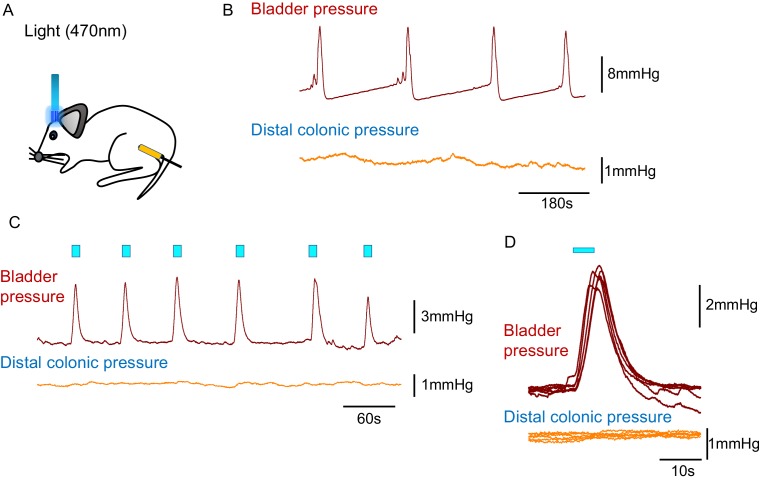
BarrCRH optoactivation does not cause contraction of the distal colon.(A, B) Simultaneous recording of bladder pressure and rectal pressure with an intraluminal balloon showed no clear relationship between colonic pressure and the micturition cycle during continuous filling cystometry. (C, D) Similarly, although opto-activation (20 ms x 20 Hz for 5 s) of BarrCRH generated bladder eNVCs, there was no corresponding response in the distal colon.